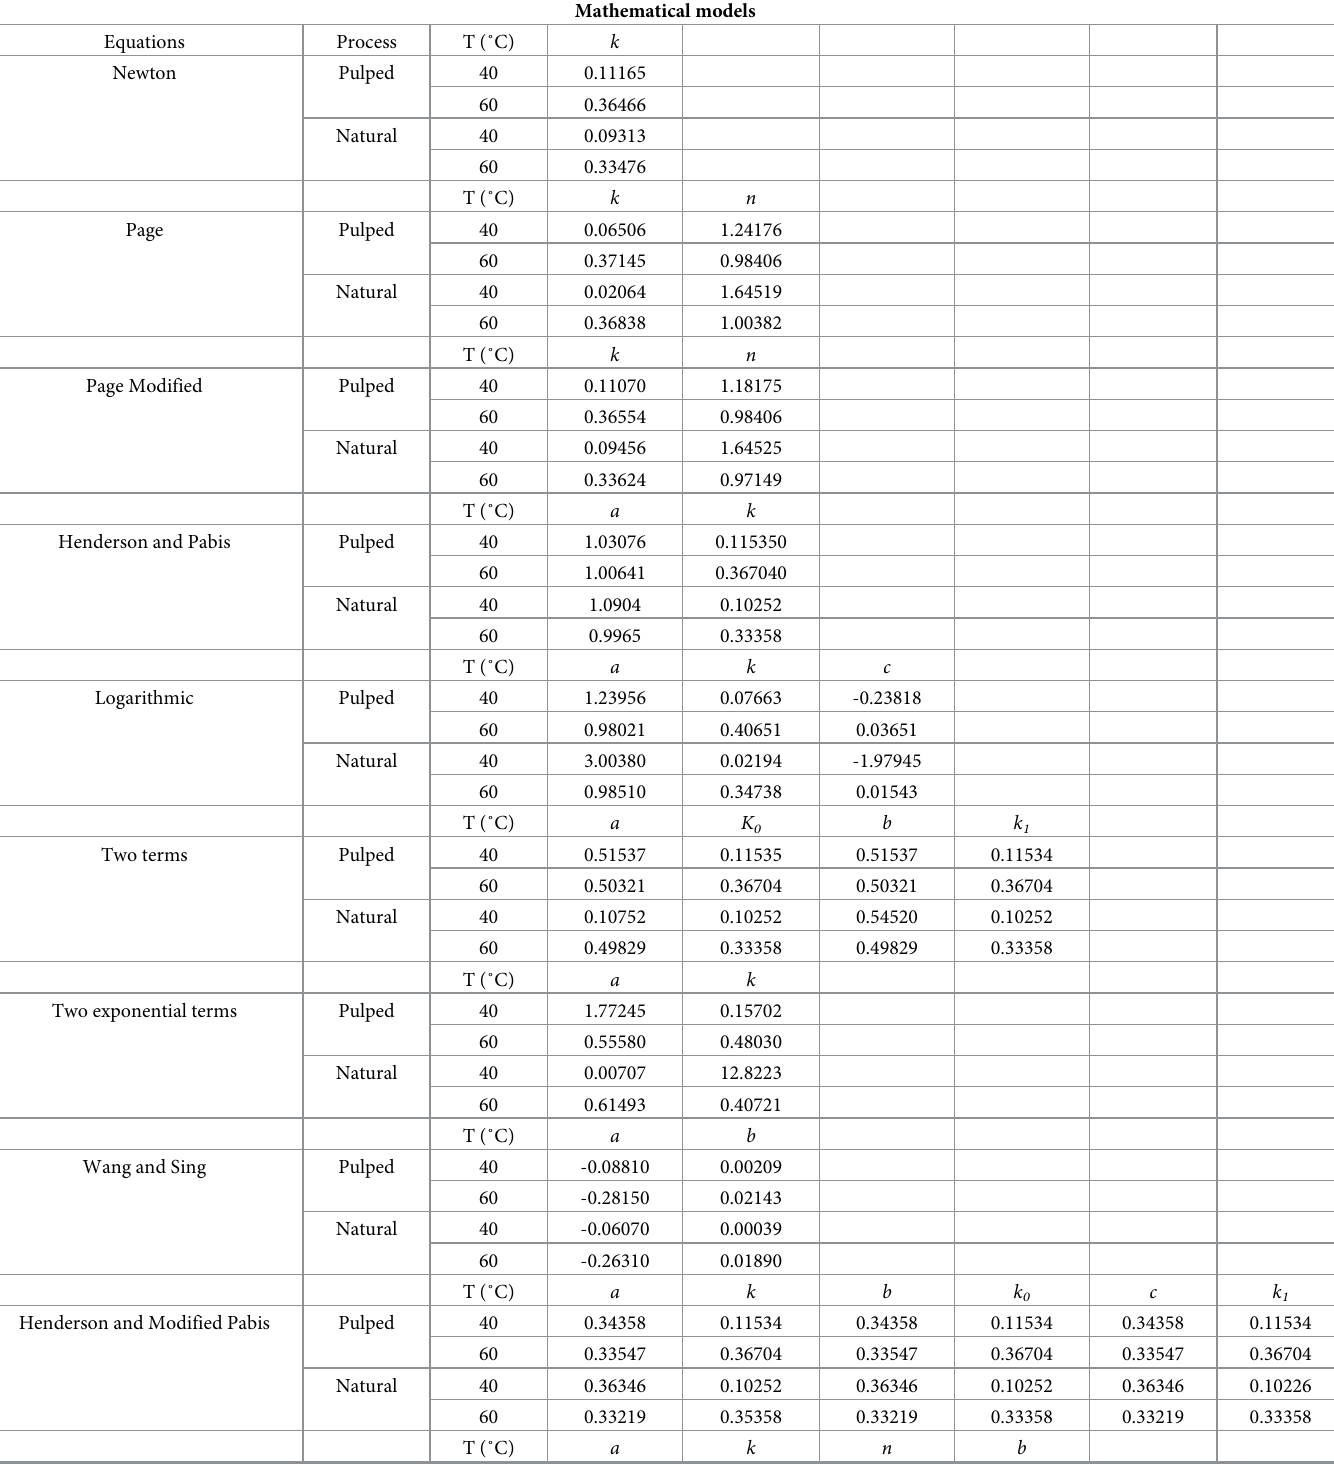
Table 2. Parameters obtained from models fitted to the data for drying of natural and pulped coffees processed with different temperatures of drying air. Mathematical